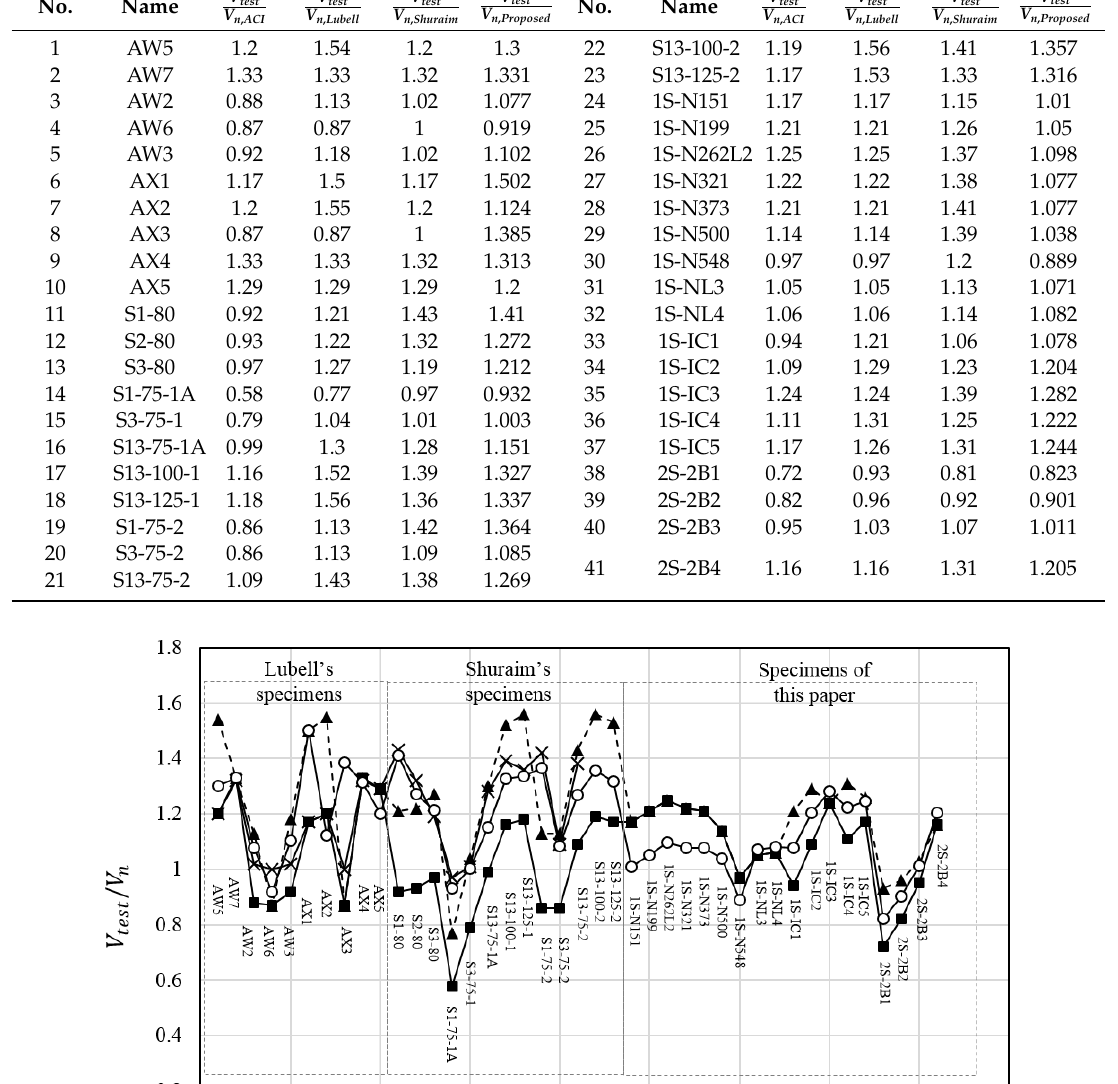
Table 6. Comparison of test results and equations.